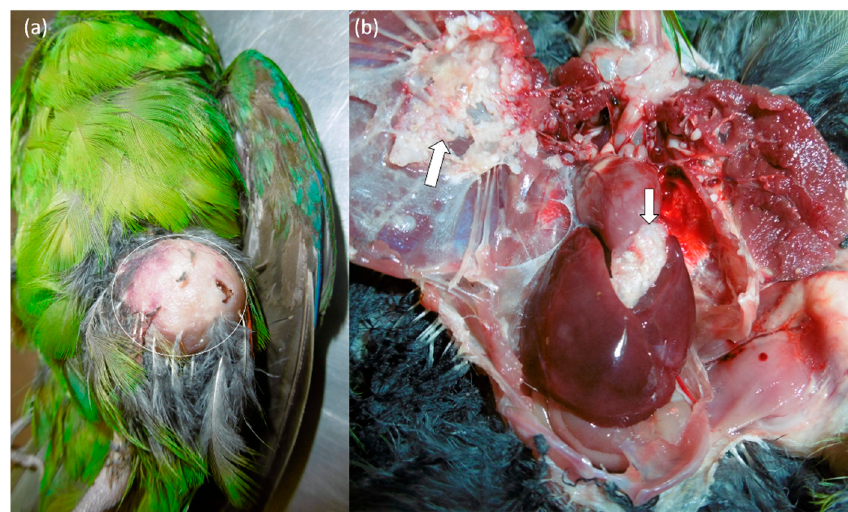
Figure 1. Red-crowned parakeet ( Cyanoramphus novaezelandiae ) labelled as case no. 1. ( a ) Yellowish- colored, firm, fascial nodular mass, 1.6 cm in diameter, on the left leg (white circle). ( b ) Situs with multiple nodules between 0.1 cm up to 0.3 cm apical in the pericardium and serosa (white arrows). Table 1. Post-mortem findings of six red-crowned parakeets ( Cyanoramphus novaezelandiae ) with psittacine adenovirus 2 (PsAdV-2) infection, including age, weight, nutritional status, gender and additional findings. Locations of xanthogranulomas are listed in fascia (Fa), lung (Lu), liver (Li), spleen (Sp) and other organs such as air sacs, serosa, pericardium and mesenterium.